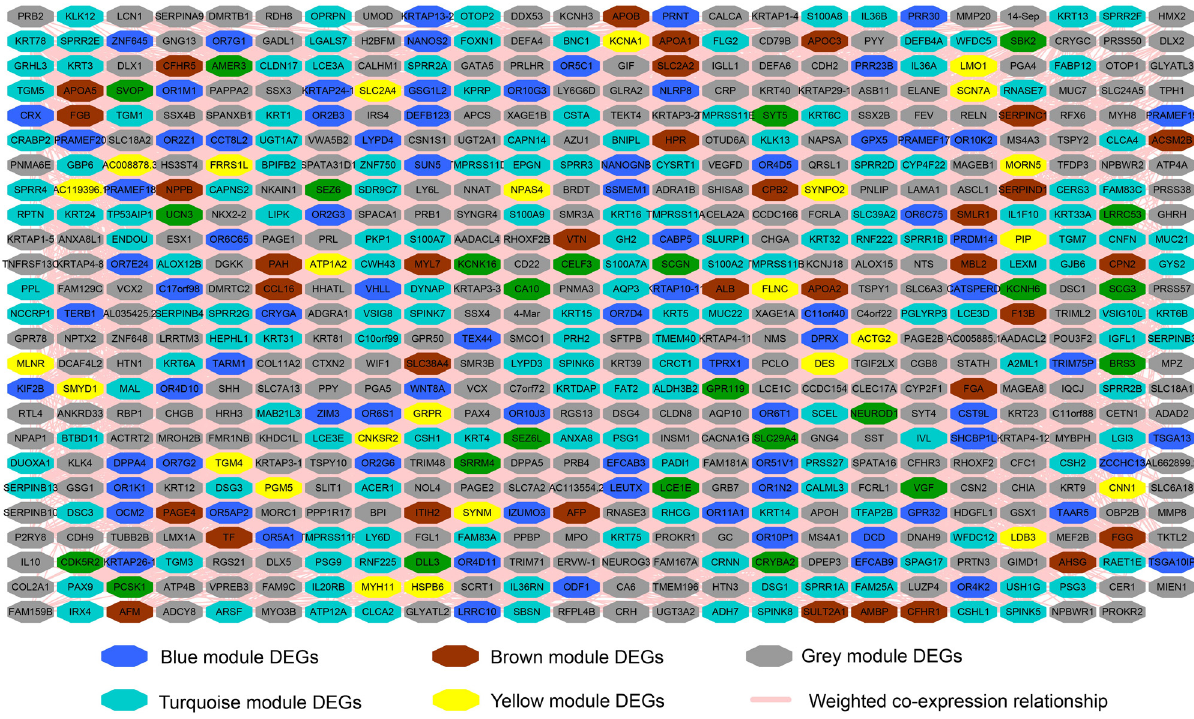
Figure 11: WGCNA interaction network of